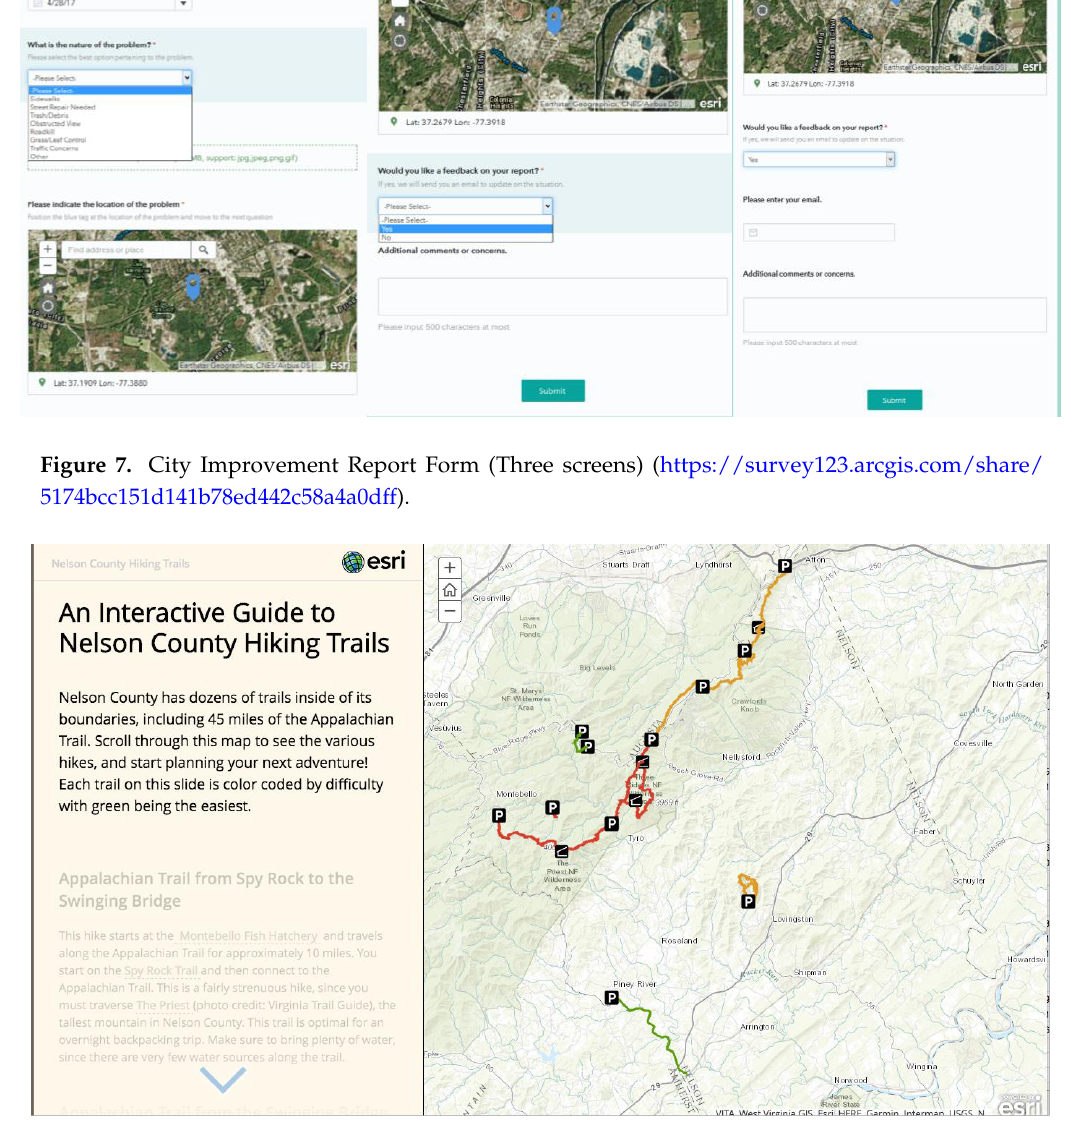
Figure 8. Interactive Guide to Nelson County Hiking Trails (https://ncps-nms.maps.arcgis.com/apps/MapJournal/index.html?appid=1bc2c7a9b90242418e518c22bf32f43a).